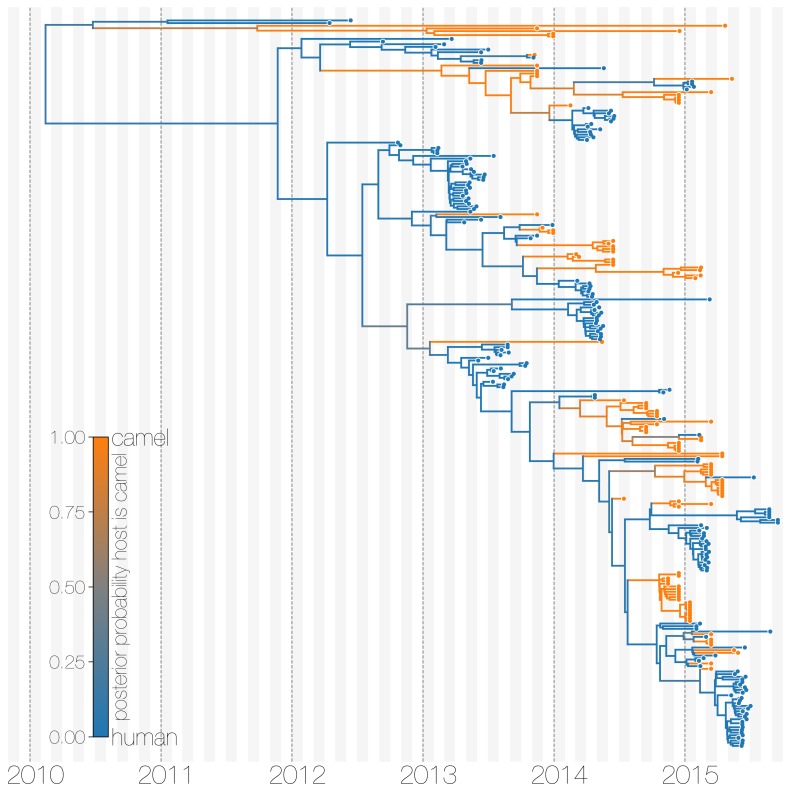
Maximum clade credibility (MCC) tree of structured coalescent model with enforced equal coalescence rates.MCC tree is presented the same as Figure 1 and Figure 1—figure supplement 3, with colours indicating the most probable state reconstruction at internal nodes. Similar to Figure 1—figure supplement 3 enforcing equal coalescence rates between demes in a structured coalescent model identifies humans as a major MERS-CoV host and the source of viruses in camels.